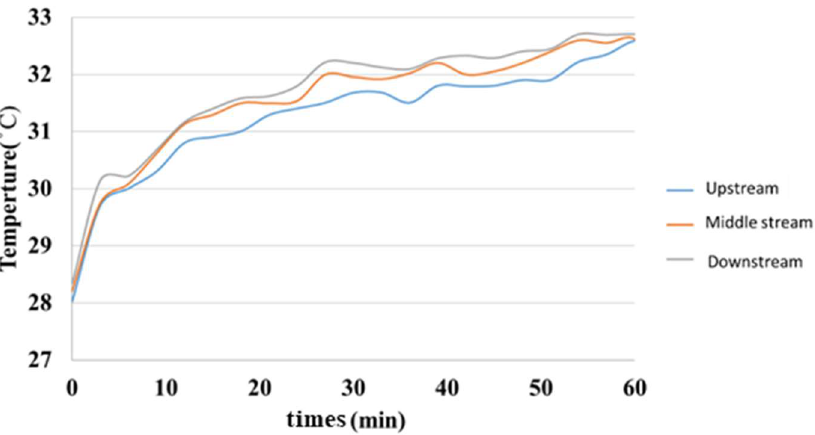
Figure 19. Internal temperature distribution of the hydrogen/vanadium redox battery.